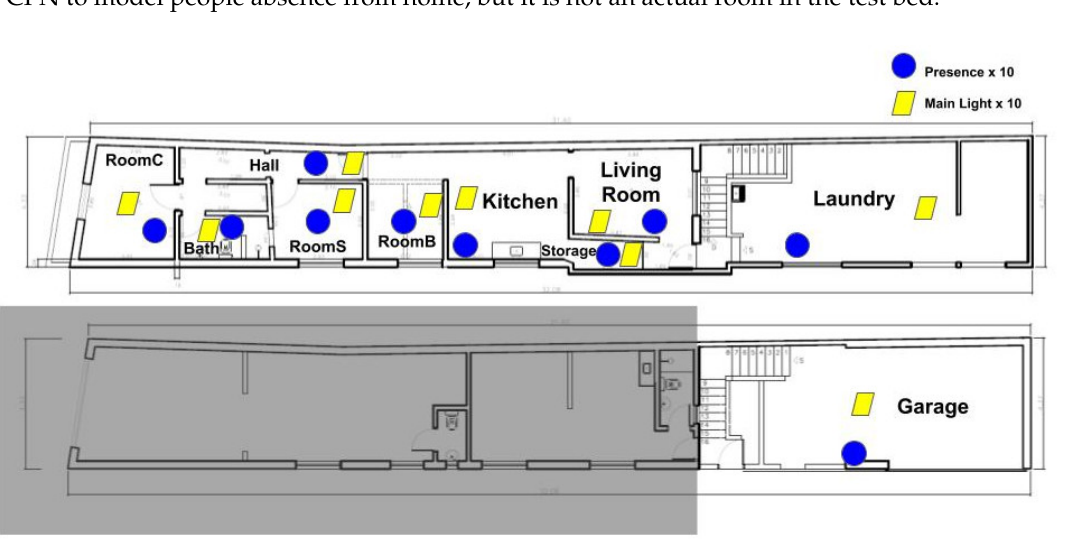
Figure 7. Layout and sensor setup of smart home test bed in Brazil. The household has two floors, and most of the house is in the upper floor. The shadowed area on the ground floor is not part of the household.